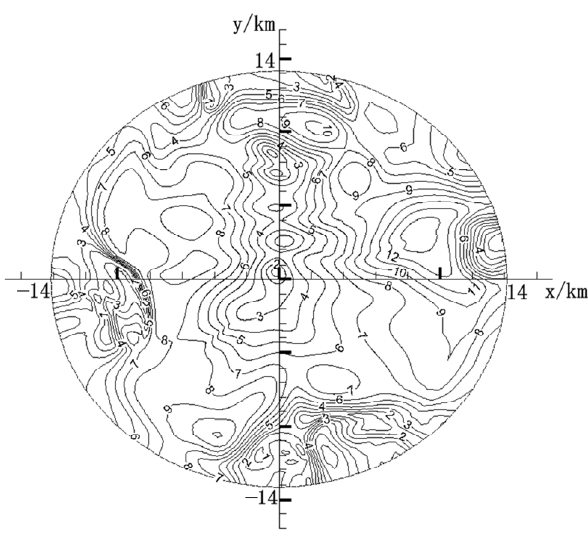
Figure 6. Horizontal velocity contours in the x–y plane, z = 1000 m, at t = 2500 s.